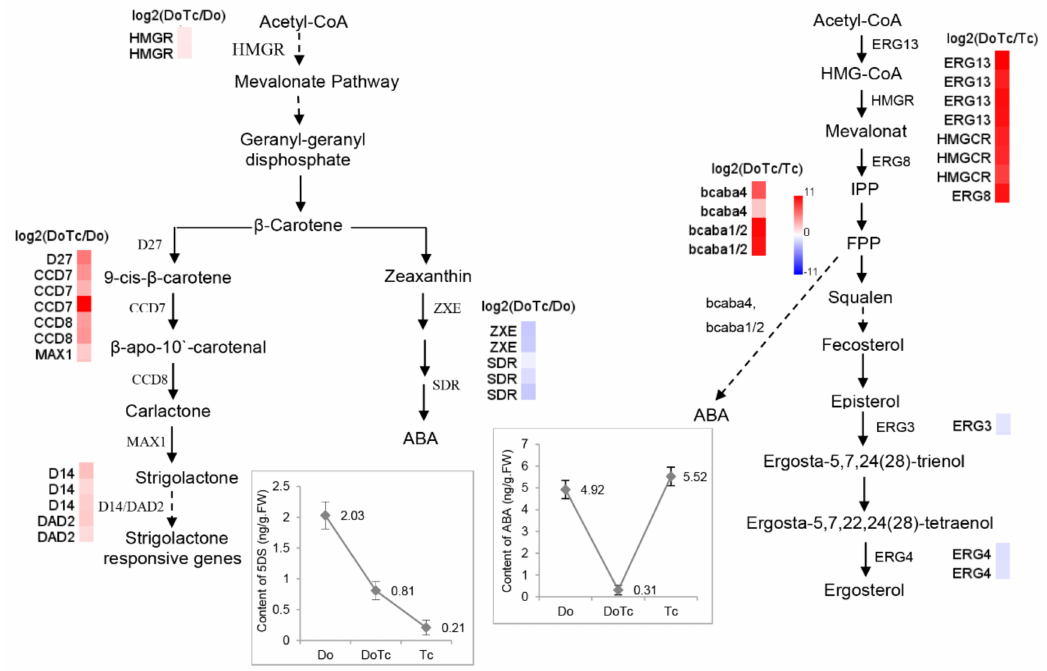
Figure 5. The diagram showing the proposed stigmasterol, ABA, and ergosterol biosynthesis pathways in the symbiotic germinated seeds of D. officinale in the symbiotic association with a Tulasnella sp. isolate. HMGR: Hydroxymethylglutaryl-CoA reductase; D27: β